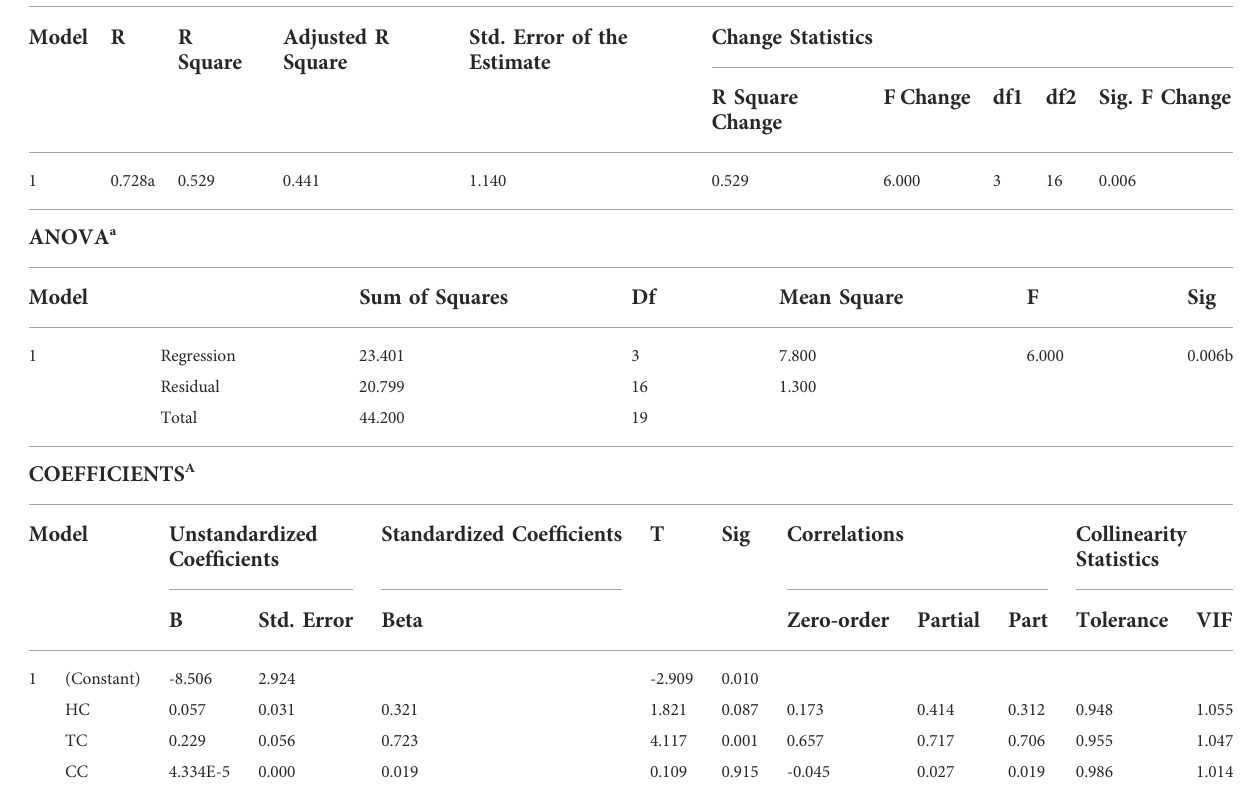
TABLE 7 Model summary, ANOVA, and coef fi cients of eye